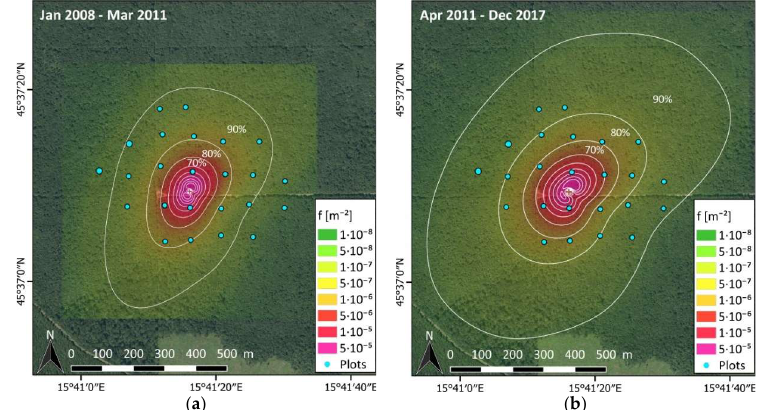
Figure 2. Flux footprint; ( a ) before the elevation of eddy covariance (EC) tower (23 m); ( b ) after the elevation of EC tower (27 m); little cyan circles denote the location of 24 circular plots. In addition, the footprint analysis confirmed that the contribution to the measured fluxes arriving from areas outside of the forest (i.e., agricultural areas, highway, and the town of Jastrebarsko with distances from EC tower of 1.2 km W, 2.4 km NW, and 5 km NW, respectively) is likely negligible. All 24 circular plots with installed dendrometer bands on trees (see Section 2.5) lay within the footprint of EC tower.